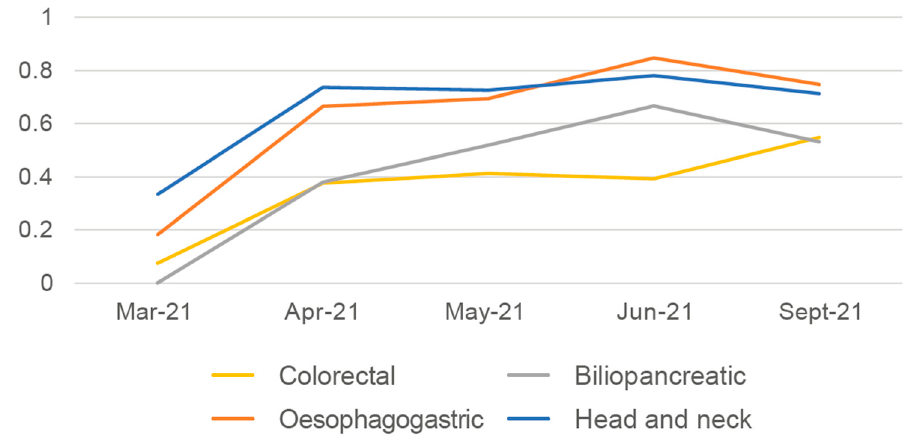
Figure 4. Average percentage of patients assessed by the NST on hospital tumour boards .